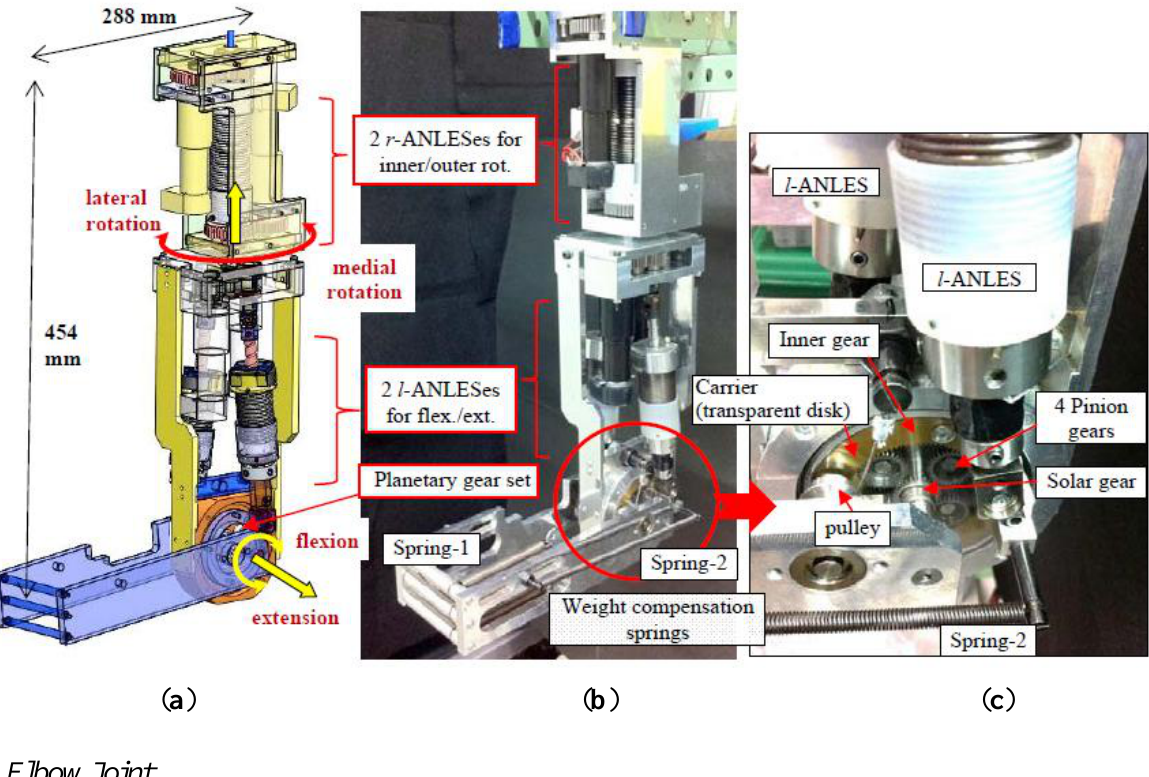
Figure 8. ( a ). Structure of the two- degree-of-freedom (DOF) upper arm; ( b ). Assembled view of the two-DOF upper arm; ( c ). Assembled view of the elbow joint